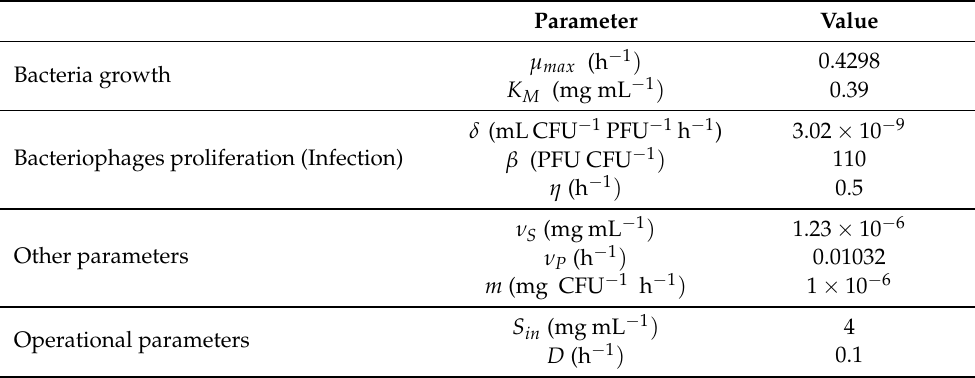
Table 2. Model parameter